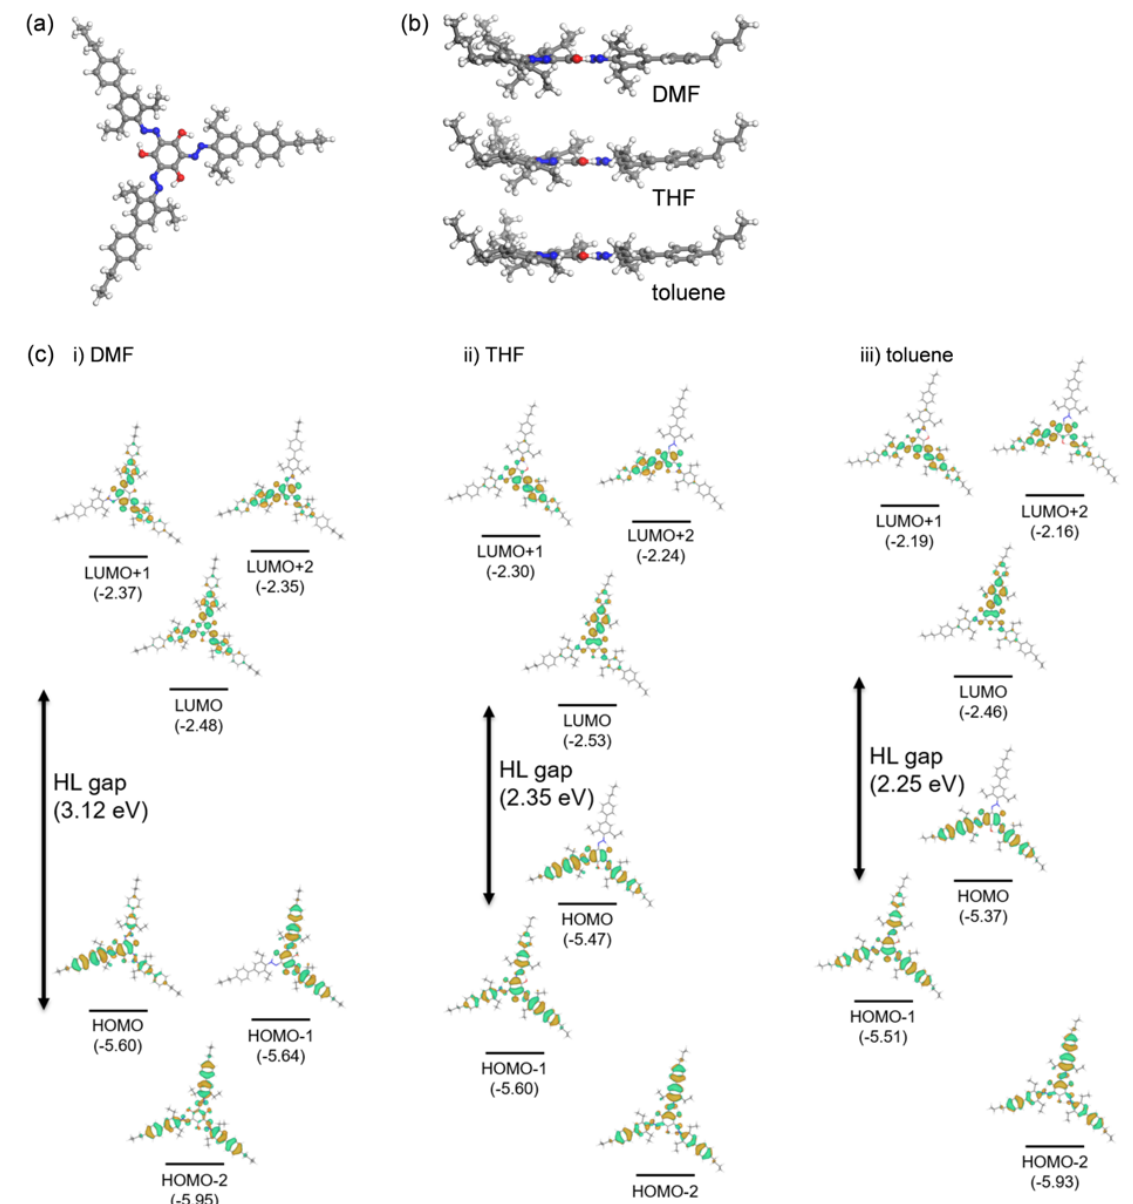
Figure 2. ( a ) Top view of 3Bu molecule optimized in DMF. ( b ) Side views of optimized 3Bu molecules in different solvent media. ( c ) Computationally estimated energy diagram for the frontier molecular orbitals of 3Bu molecule in different solvent media, the influence of which was accounted for using SCRF approximation.